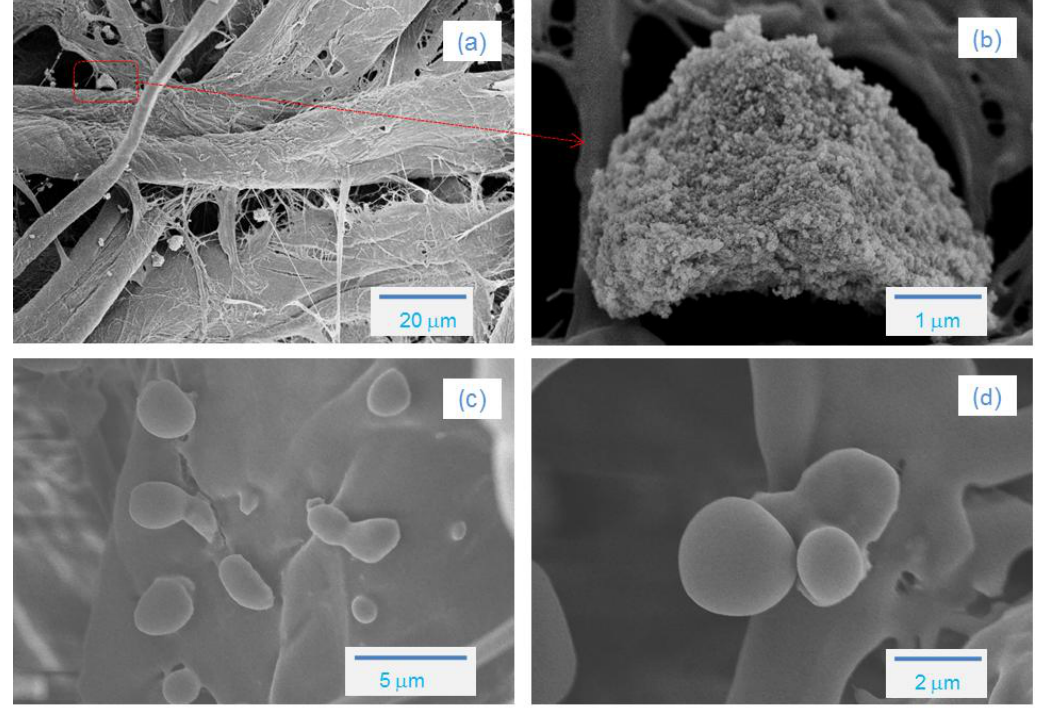
Figure 5. FE-SEM photos of the aerosol; (a) and (b) humid air, (c) and (d) humid N Benzene concentration was about 250